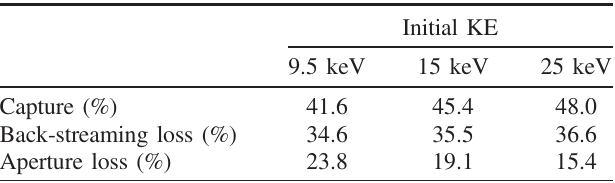
TABLE I. Simulated capture efficiency and loss of commercial